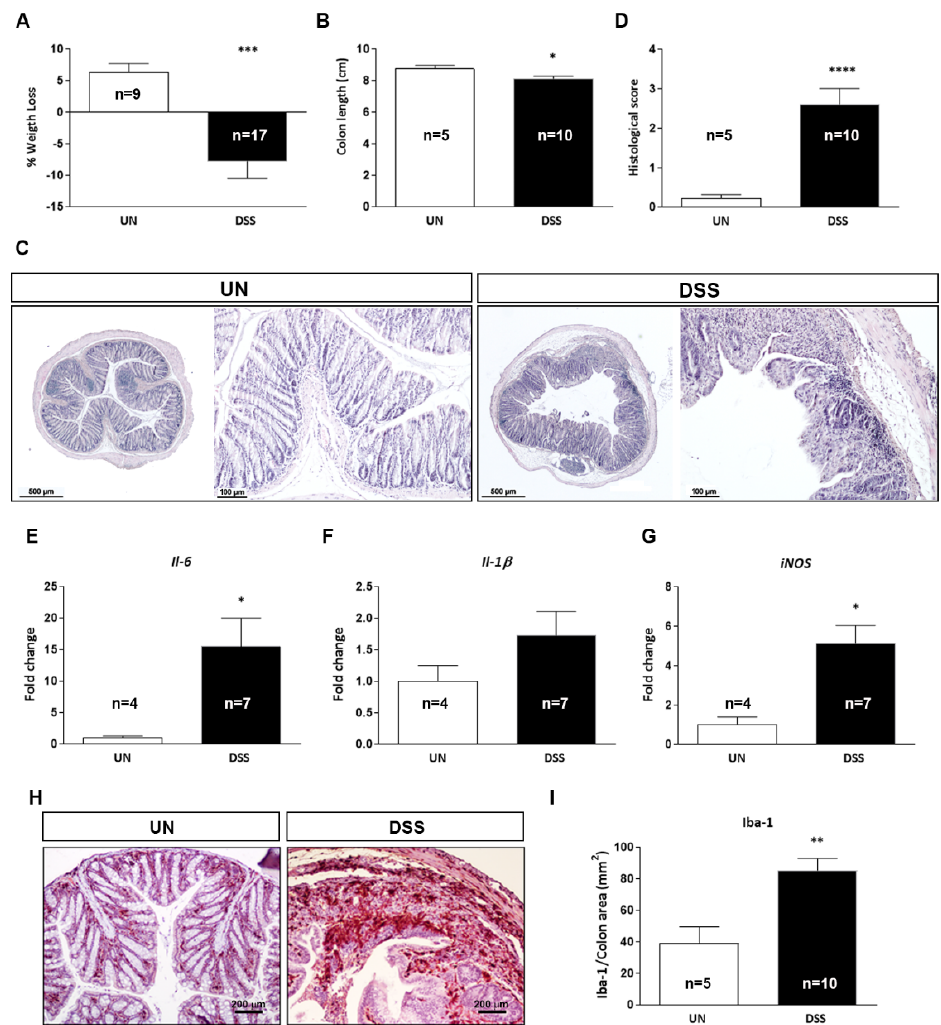
Figure 2. Macroscopic, molecular and histological analyses in the colon of C57BL/6 mice with DSS-induced acute colitis. Body weight loss ( A ) and colon length ( B ). Representative colon sections from DSS-treated and untreated mice ( C ) and relative histological score ( D ). mRNA expression levels of proinflammatory cytokines ( E ) Il - 6 , ( F ) Il - 1 β and of the oxidative stress marker ( G ) iNOS were analyzed by qPCR. Representative images of microglial marker Iba-1 expression by IHC ( H ) and relative quantification ( I ). UN: untreated group; DSS: sodium dextran sulfate treated group. The number of mice used per test is indicated in the graphs (n). Data are reported as mean ± SEM, * p < 0.05; ** p < 0.01; *** p < 0.001; **** p < 0.0001 for comparison with controls.